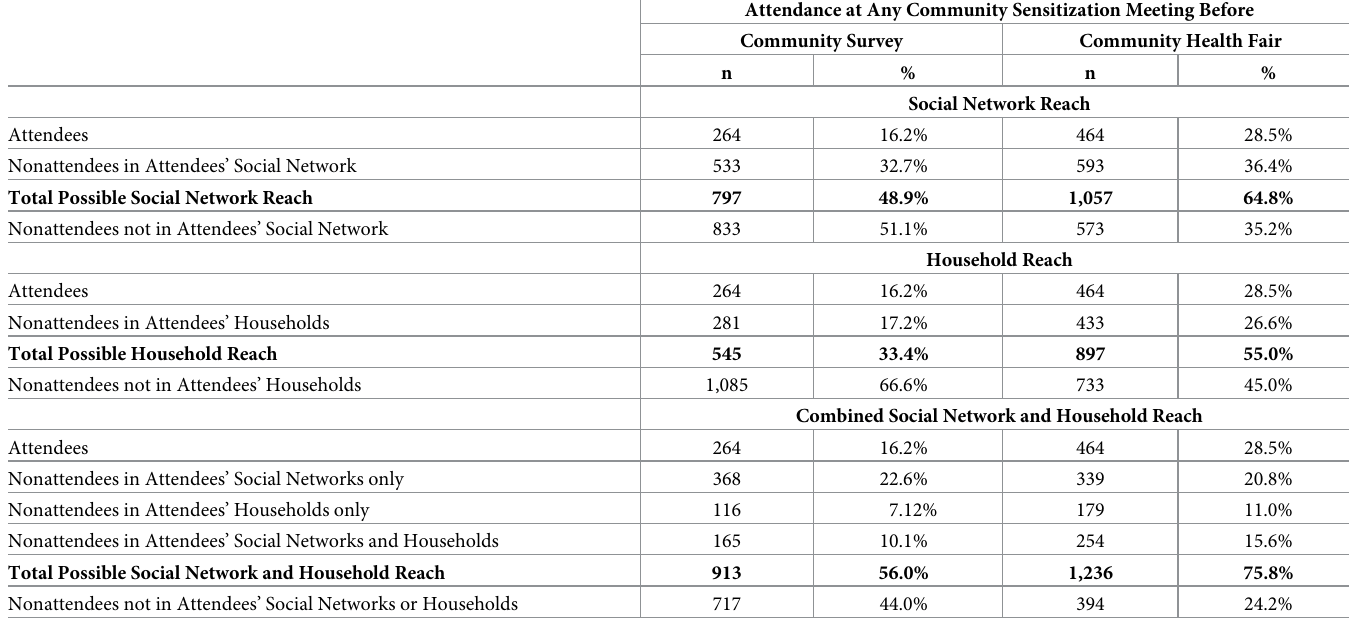
Table 4. Reach of community sensitization meetings through attendees’ social networks and